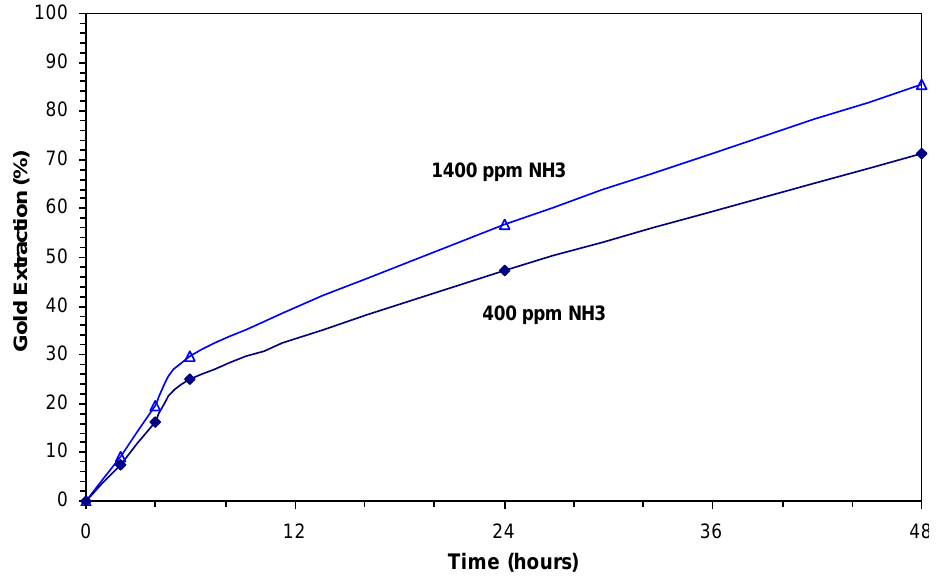
Figure 8. Hunt leaching tests at high cyanide concentration; 0.3% Cu as bornite, 850 ppm NaCN, pH 11.7–11.9, 8 ppm